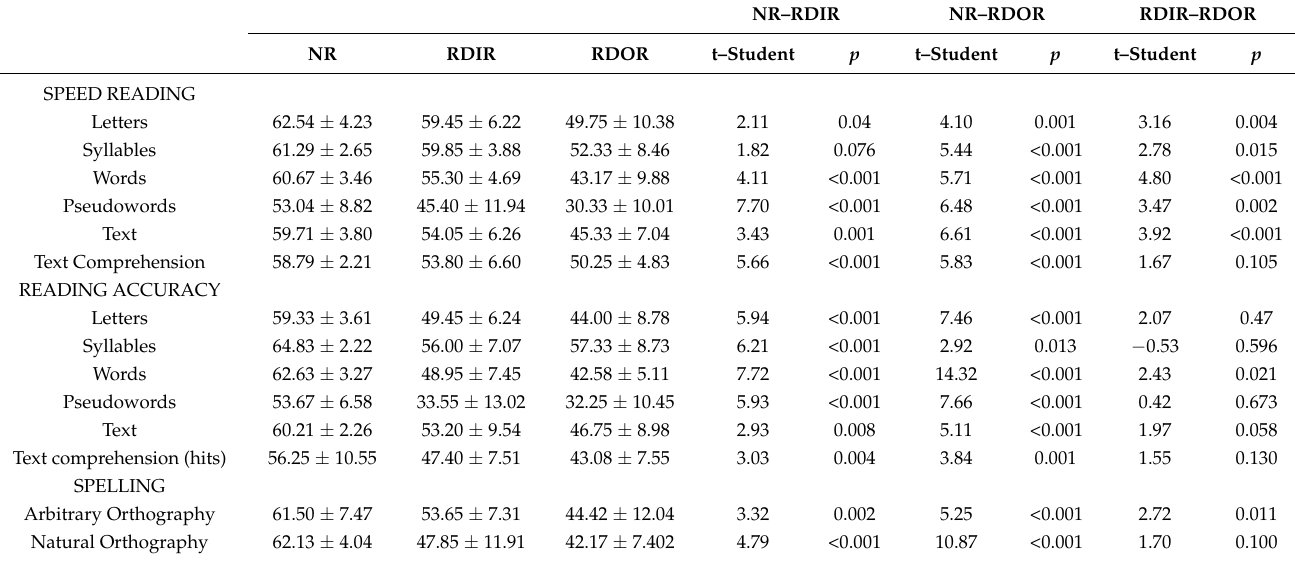
Table 3. Comparison of performance at